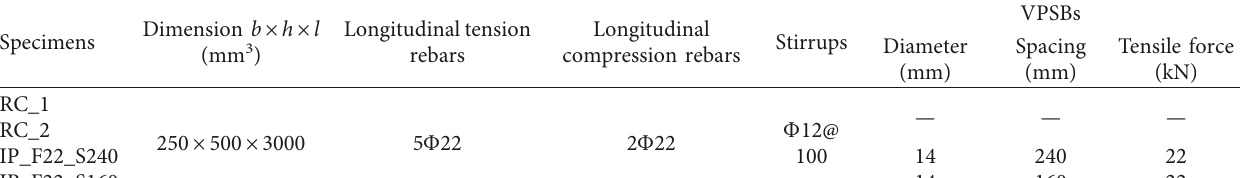
Table 2: Main parameters of test beams.